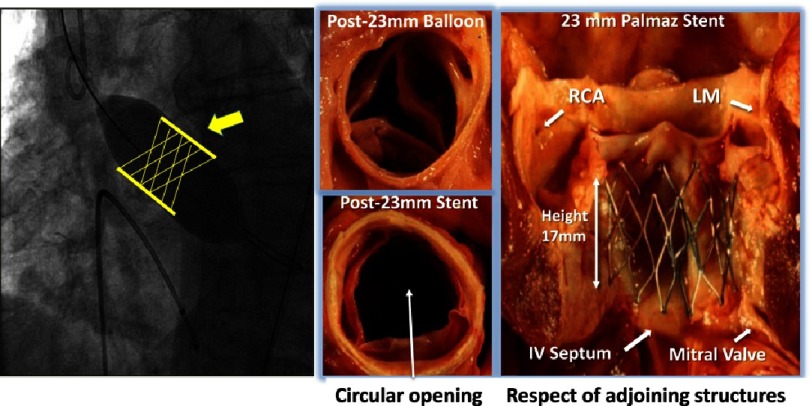
Birth of the idea of “stented-valve” in AS.Left panel: A stent crimped over a high-pressure valvuloplasty balloon might keep the valve open and prevent restenosis. A valve structure should be added within the stent. Right panel: Validation of the concept of intra-valvular stenting and optimal height of the frame to respect adjoining structures.